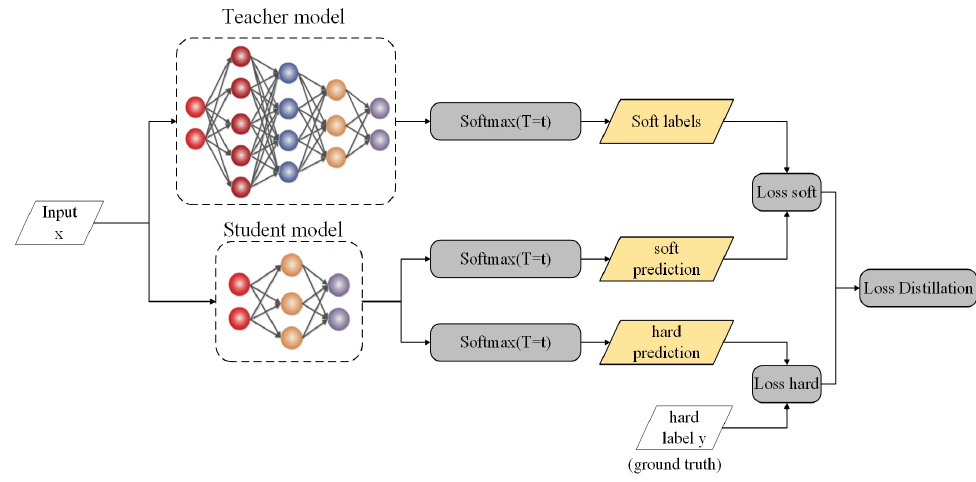
Figure 6. The structure of the GS bottleneck and VOV-GSCSP. ( a ) the structures of the GS bottleneck; ( b ) the structures of the VOV-GSCSP. Where GS bottleneck is the Ghost-Shuffle bottleneck; VOV- GSCSP is one-time aggregation cross stage partial network module.